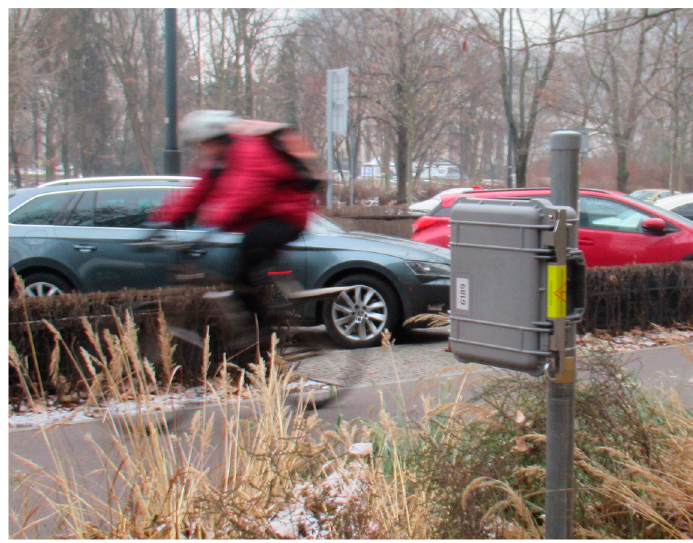
Figure 1. Microwave radar installed next to a bicycle lane (own